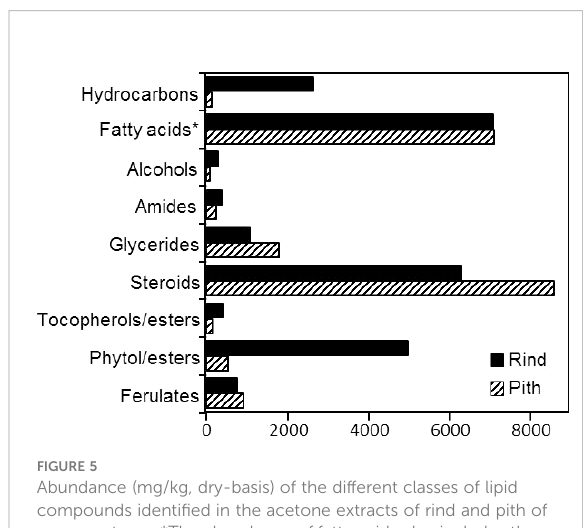
FIGURE 5 Abundance (mg/kg, dry-basis) of the different classes of lipid compounds identi fi ed in the acetone extracts of rind and pith of papyrus stems. *The abundance of fatty acids also includes the 2-hydroxyfatty